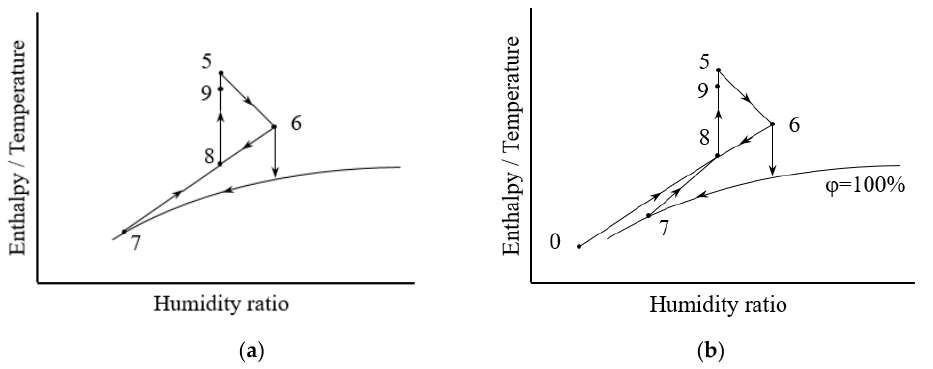
Figure 2. Mollier h, Y-chart showing air cycle in drying chamber for: ( a ) the CHPD, ( b ) the HPDU.